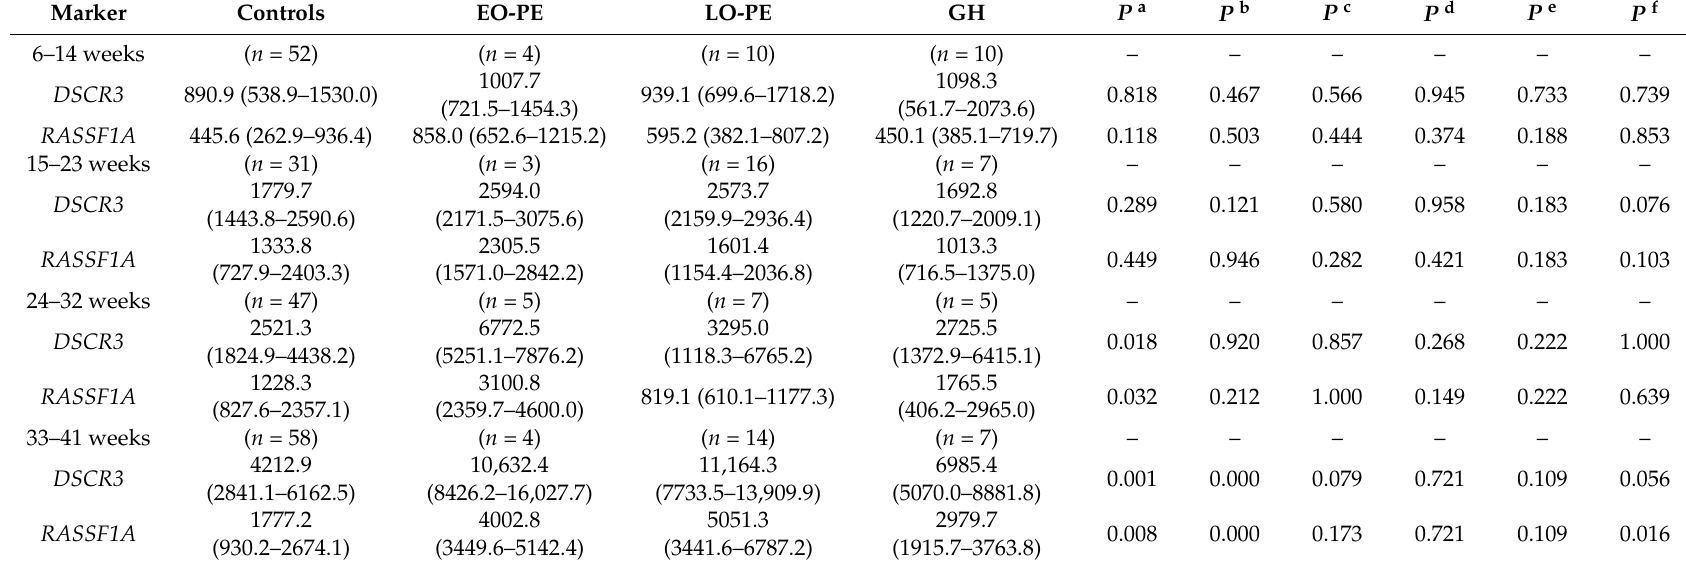
Table 3. Maternal plasma concentrations of epigenetic markers in control and patient groups during